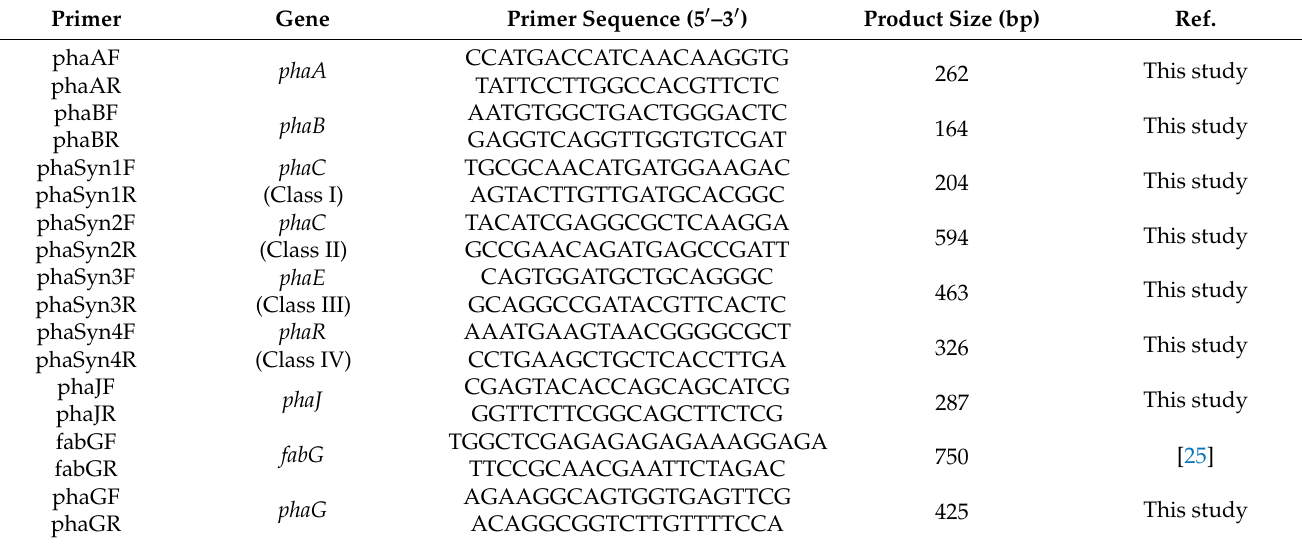
Table 4. Used primers and sizes of their PCR